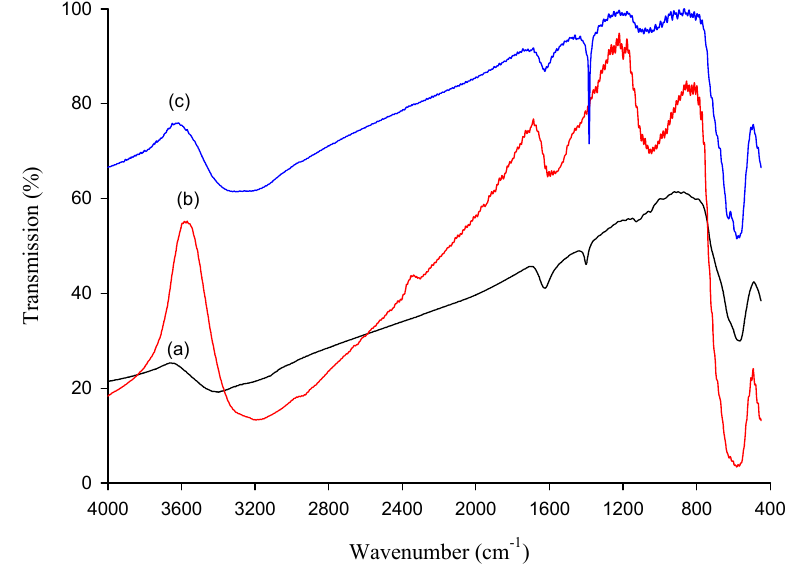
Figure 1. FTIR spectra of ( a ) MNP, ( b ) MNP-Tu and ( c ) Au(III)-loaded